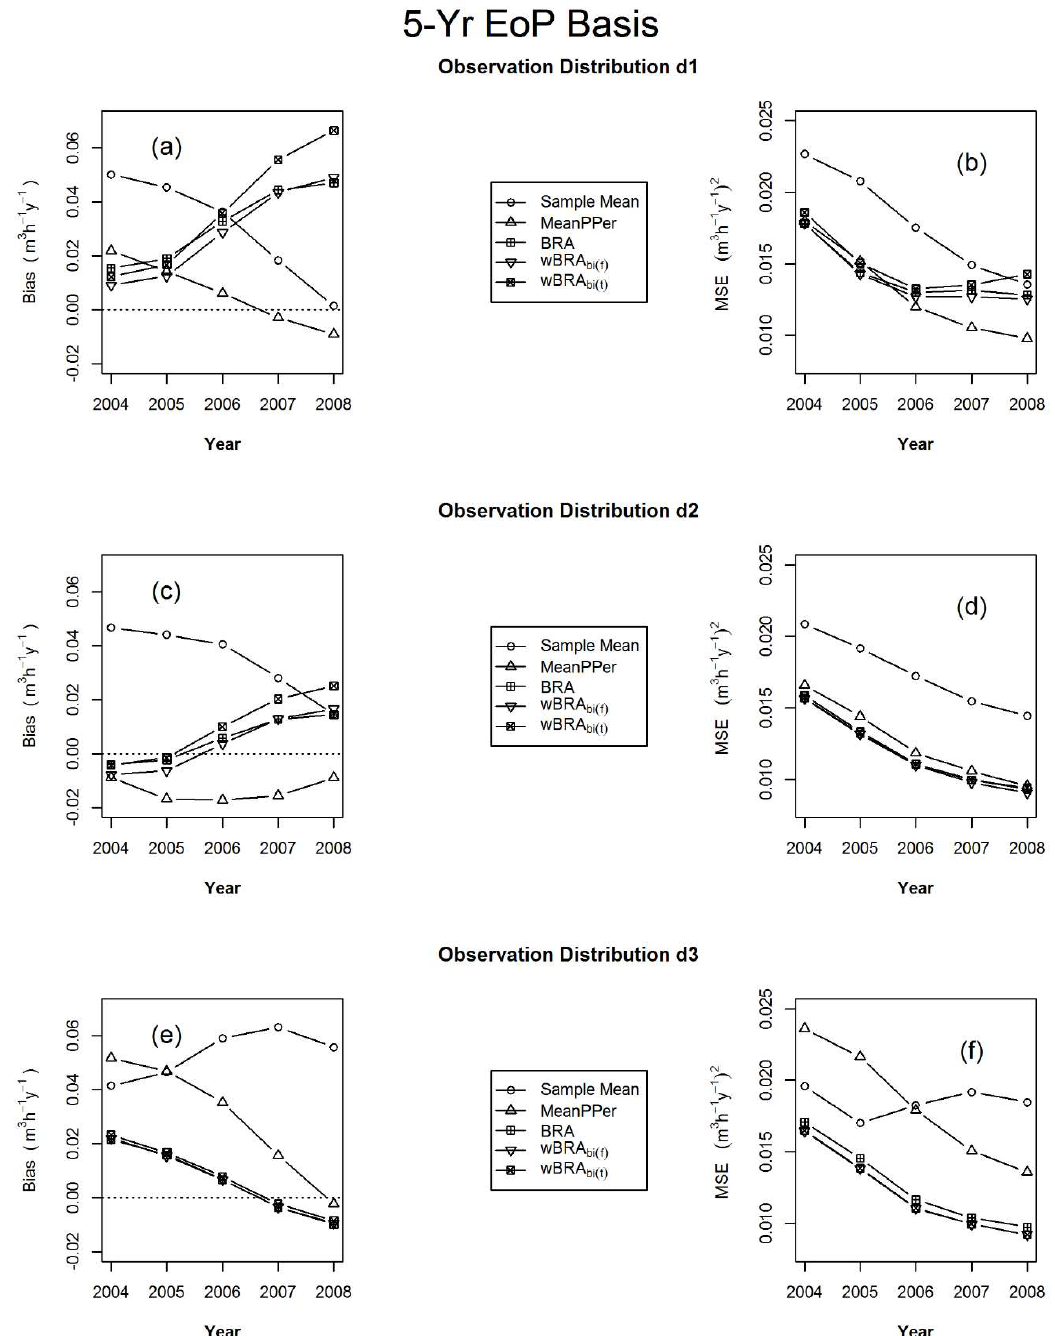
Figure 8. The simulation mean bias in the left graphs ( a , c , and e ) and the simulation mean of mean-squared errors in the right graphs ( b , d , and f ) for Estimand 3 (with a five-year EoP basis), for each distribution d1 through d3, from top to bottom, respectively. These summary statistics were compiled after 100 iterations of composite samples of size 1000, for each of five sample observation lengths, within each of the 125 populations.